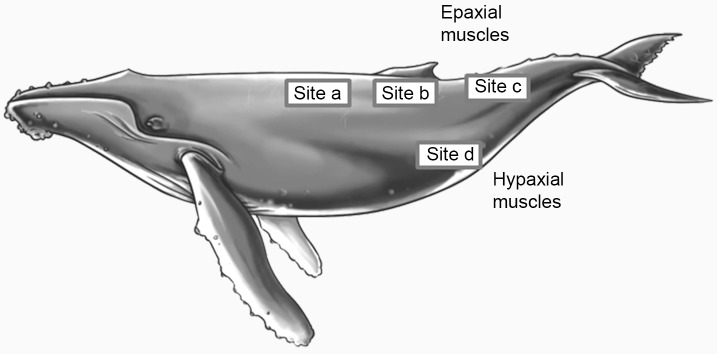
Sampling sites used for the provision of muscle tissue samples from mysticetes.(based on Polasek and Davis [43]). Picture credit: Yvette Hansen.